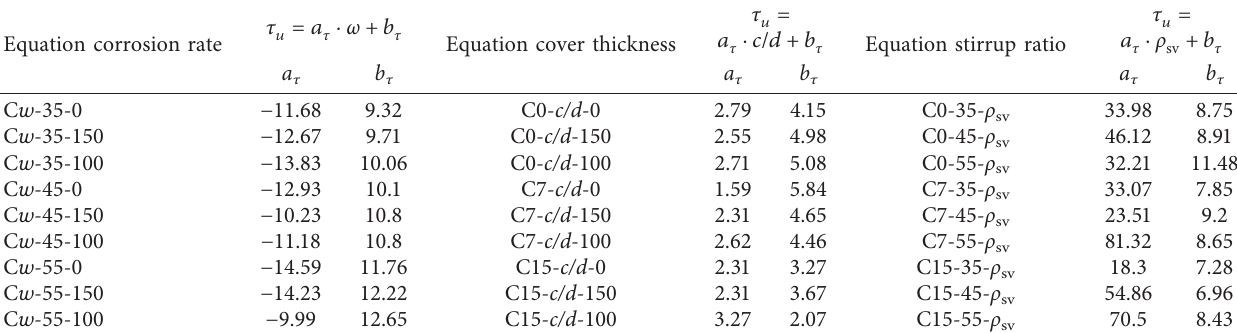
Table 4: The expression of the ultimate bonding strength and corresponding parameter.